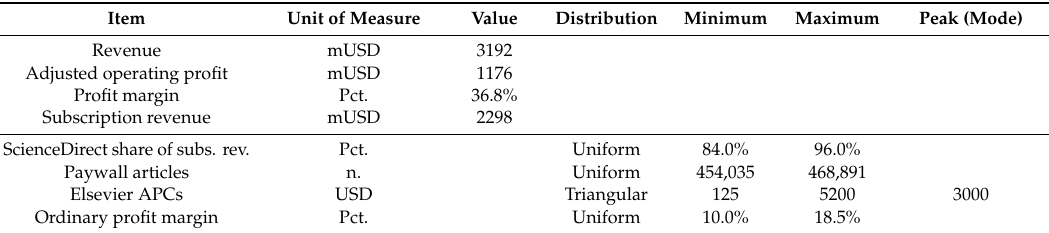
Table 3. Summary of data and assumptions for the Monte Carlo simulation (2017).